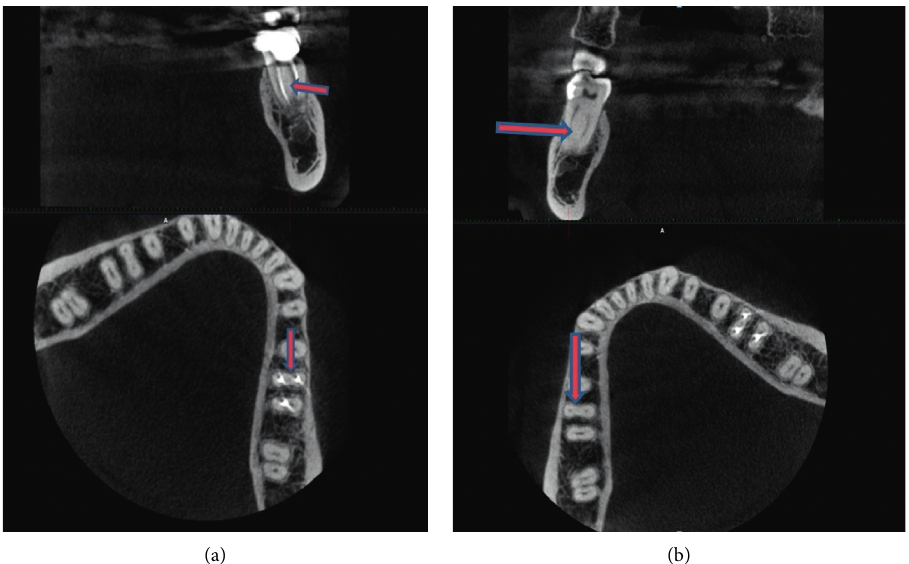
Figure 2: Case 2: a 32-year-old male with bilateral middle mesial canals in the mandibular first molars, showing just one canal in the distal